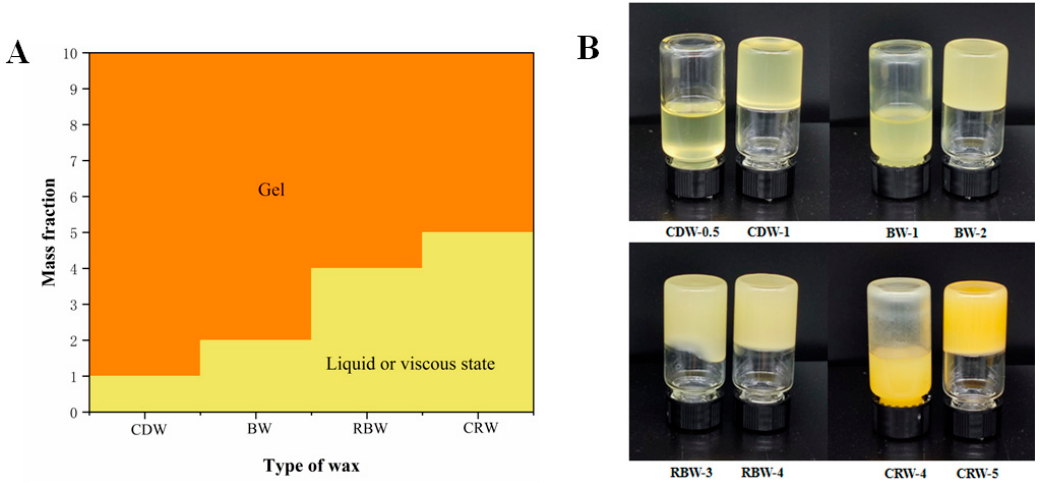
Figure 1. ( A ) Phase diagram of oleogels formed using natural waxes at different mass fractions (wt.%). ( B ) Critical concentration of wax-based oleogels at 25 °C.